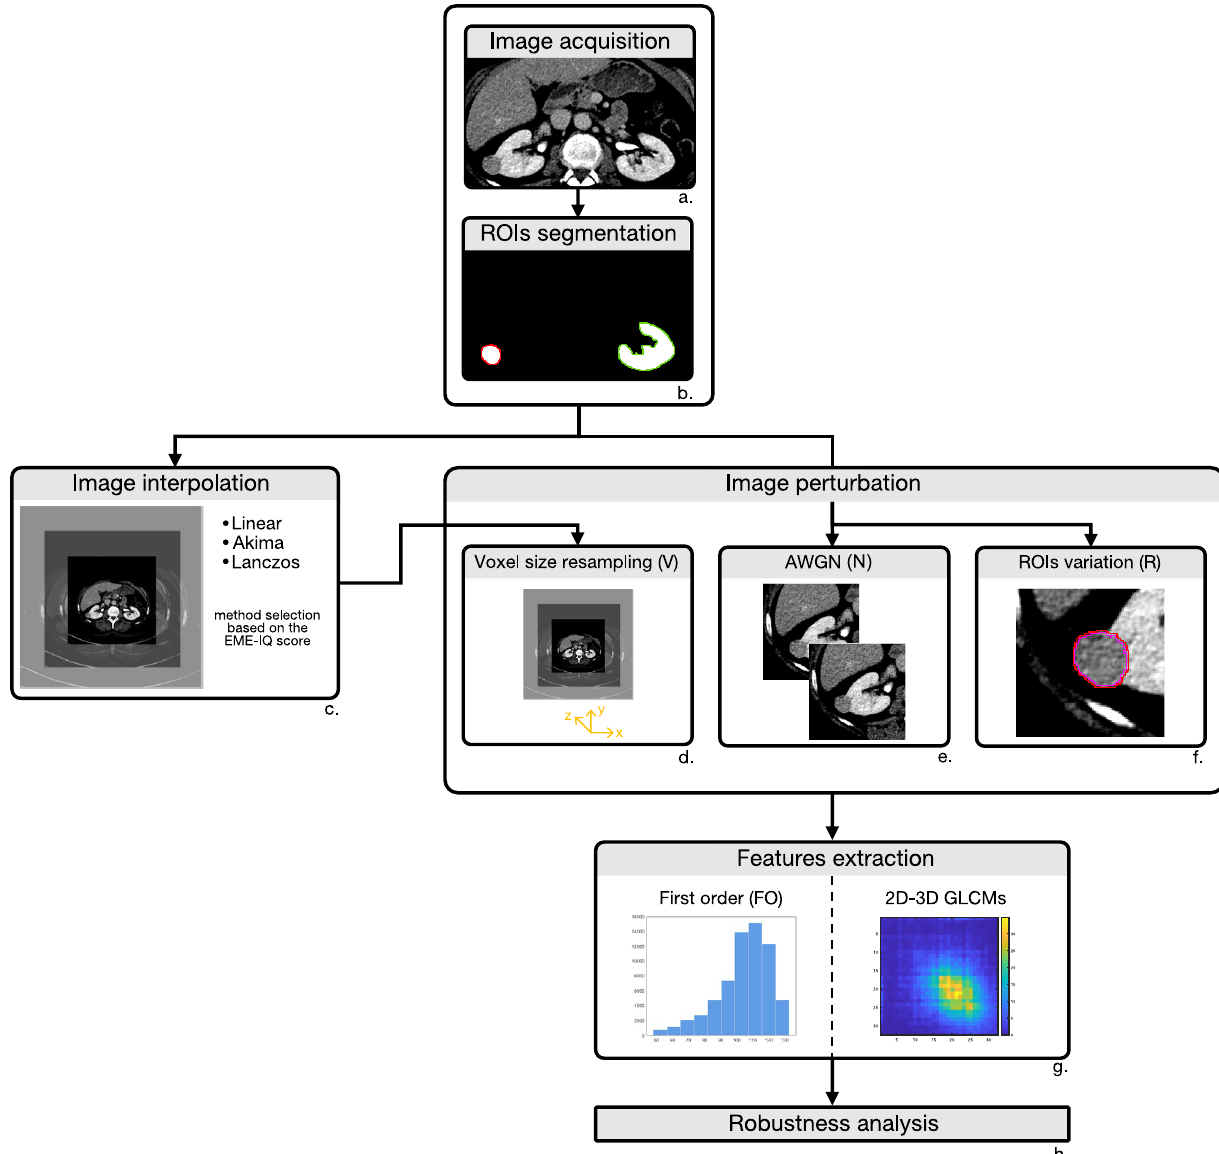
Figure 1. Workflow of CT image processing for feature robustness analysis. First, CT images were acquired ( a ) and ROIs segmented ( b ). Then, one out of three resampling methods was chosen based on the highest EME-IQ score ( c ), then CT images were perturbed by changing resolution ( d ), noise addition ( e ), and ROI variation ( f ). Finally, first order, and 2D and 3D texture features based on GLCMs ( g ) were extracted from original and perturbed images and robustness analysis was performed ( h